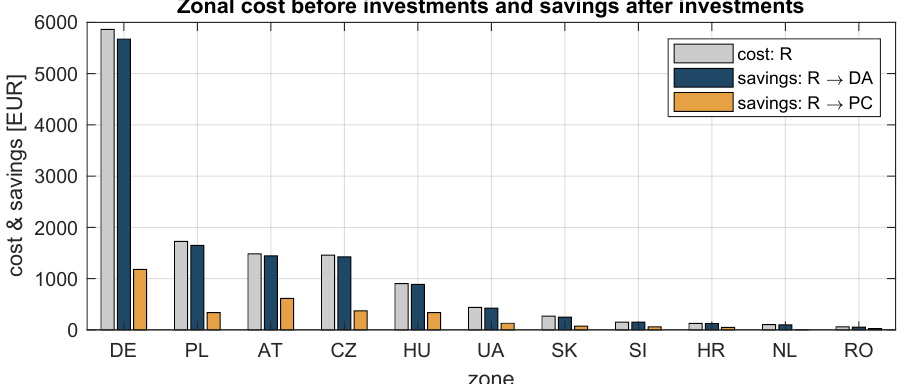
Figure 6. Zonal costs (R) and savings due to investments on German-Austrian (R → DA) or Polish-Czech (R → PC) border.